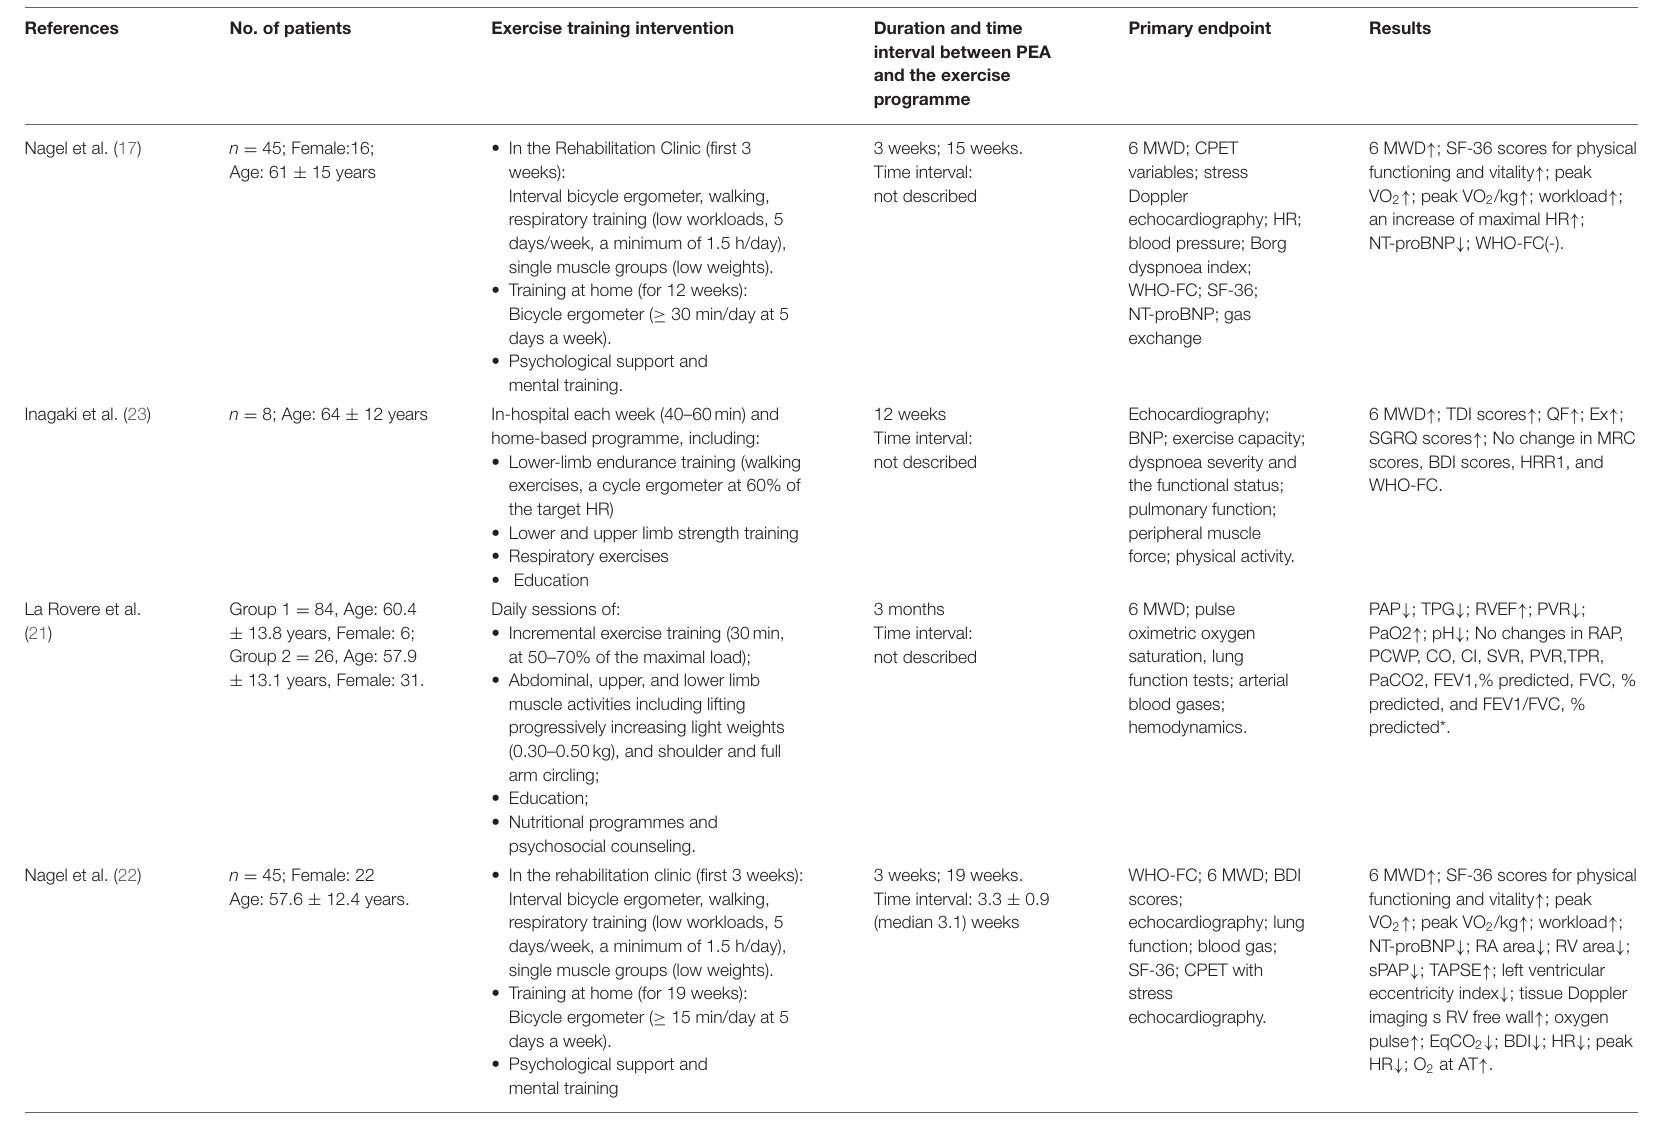
TABLE 1 | Characteristics of all included